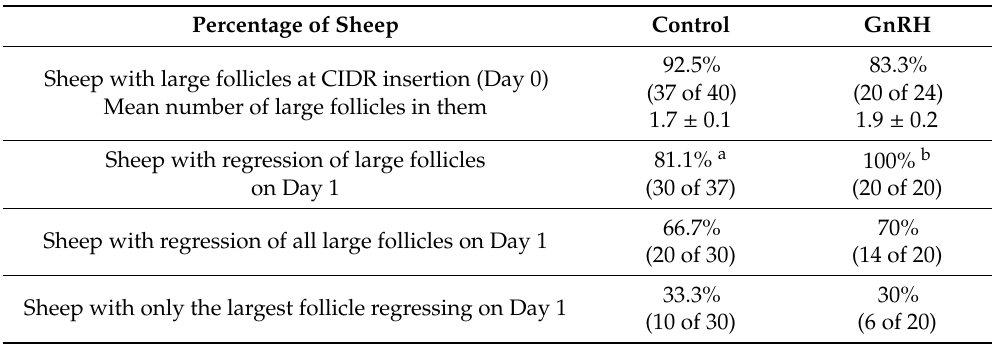
Table 1. Percentage of sheep showing presence of ≥ 4 mm follicles at CIDR insertion (day 0) and e ff ects of CIDR insertion alone (control group) or combined with a single GnRH dose (GnRH group) on regression of such follicles on day